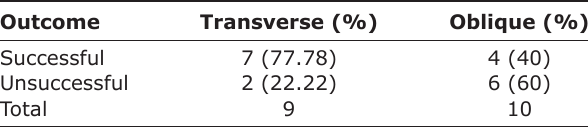
Figure-6: Complications of C-arm guided pinning: Missing the proximal fragment. (a) Pin missing the proximal fragment of the bone, (b) Pin missing the proximal fragment of the bone Table-2: Fracture configuration wise success rate of C-arm guided intramedullary pinning.